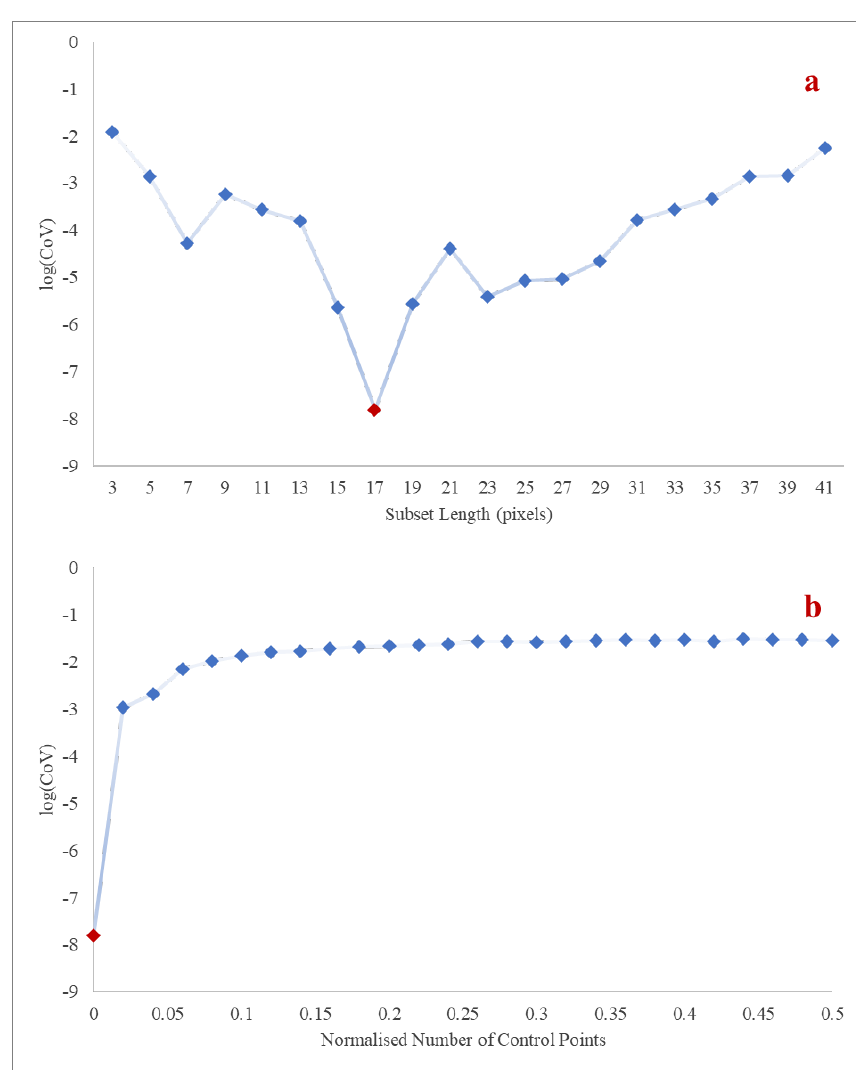
Figure 3. Microscopy image of the reference condition of the tensile test specimen and illustration of position and dimensions of the region of interest (ROI) in units of micron, obtained using an Alicona Infinite Focus 3D Profilometer instrument. Metals 2020 , 10 , x FOR PEER REVIEW